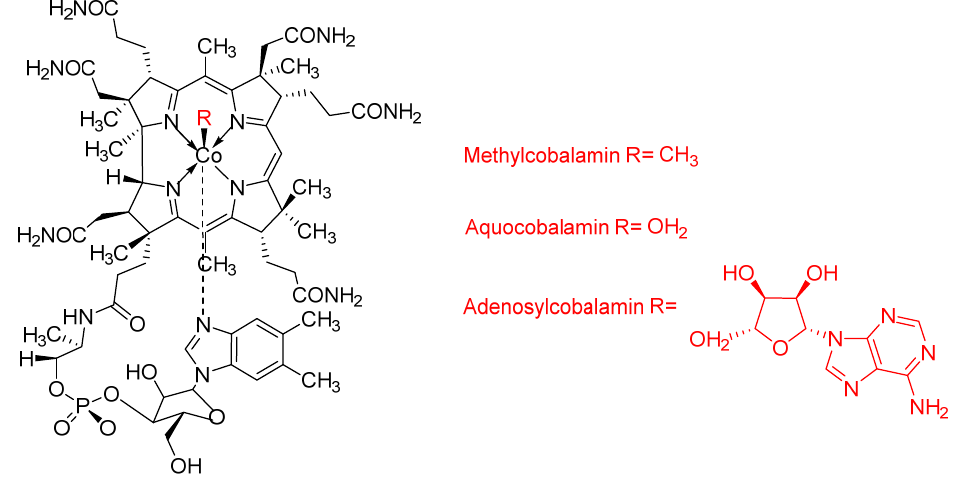
Figure 15. Molecular structures of cobalamins synthetized by Chemaly et al. [53] that were 40 times more effective than chloroquine in inhibiting β -hematin formation in vitro.